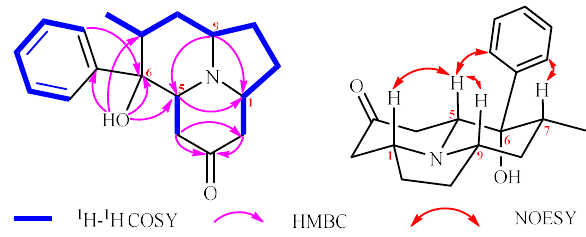
1 H- 1 H COSY, HMBC, and NOESY correlations of 2 . Figure 4.